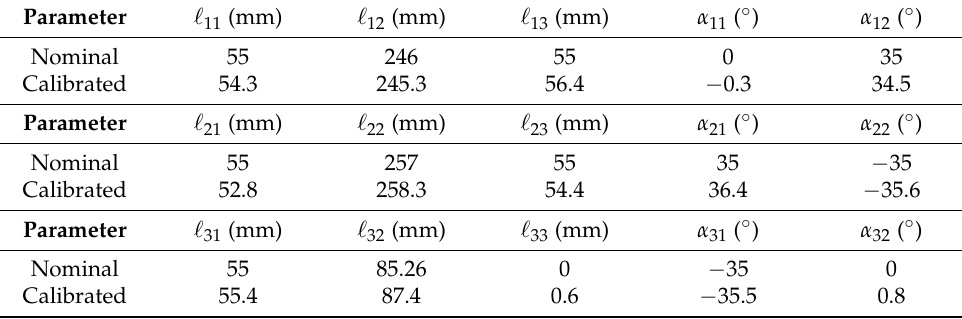
Table 5. Nominal and calibrated values of link